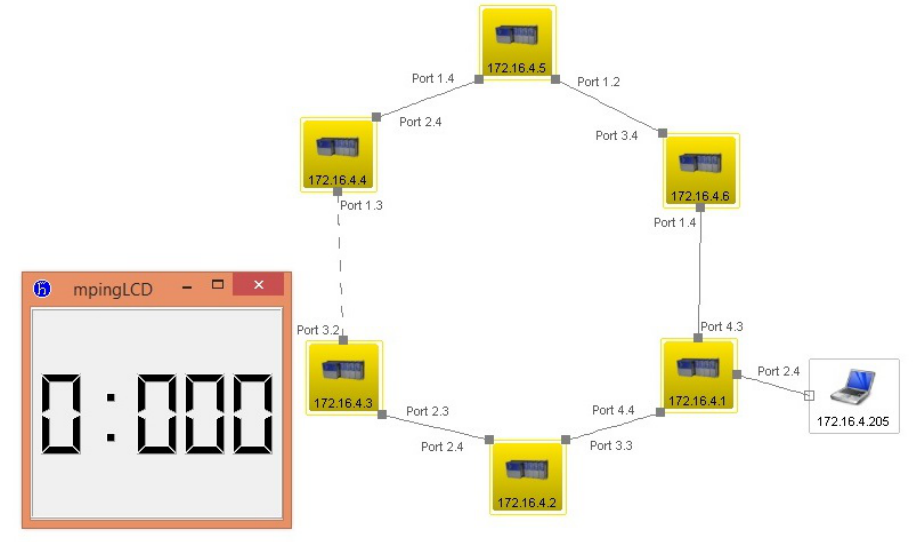
Figure 16. RSTP ring network with no cable